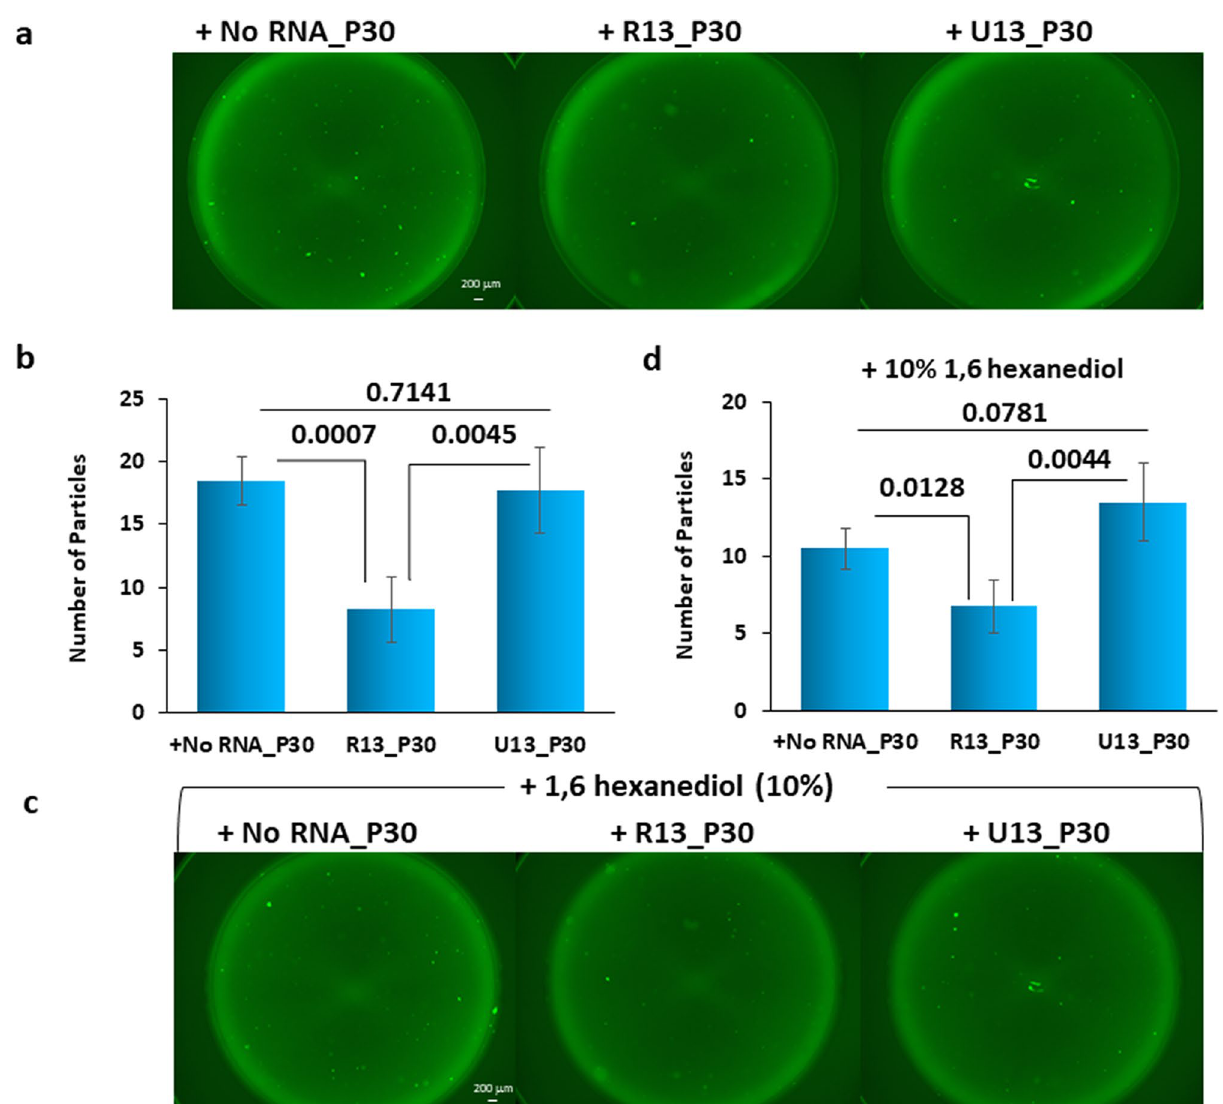
Figure 5. R13 represses the aggregation of FUS caused by pipetting while U 13 cannot, as revealed by fluorescence microscope images. ( a ) Representative fluorescence microscope images of 100 nM FUS fusion protein (Strep-GFP-FUS) after the addition of an equimolar amount of either no RNA, R13 or U 13 and subsequent application of 30 strokes of pipetting. ( b ) A bar graph showing the numbers of particles > 0.002 mm 2 . The bar graphs show the averages of 3 independent experiments ± SD. p values are indicated. ( c ) Images after addition of 10% 1,6-hexanediol to the samples shown in ( a ). ( d ) A bar graph showing the numbers of particles > 0.002 mm 2 for images shown in ( c